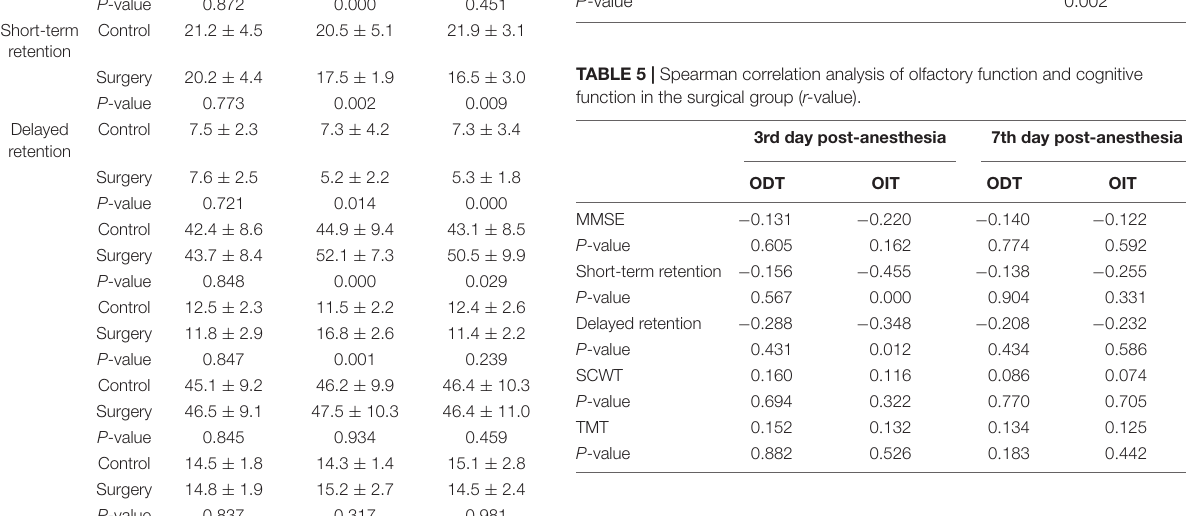
Frontiers in Molecular Biosciences |